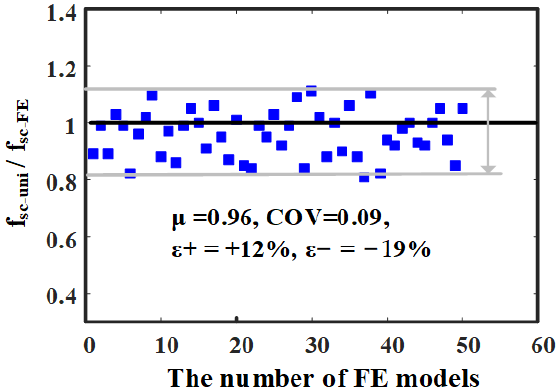
Figure 6. Comparison of the compressive strength (f sc ) determined by the proposed formula against the numerical results from FE stub column models. the numerical results from FE stub column